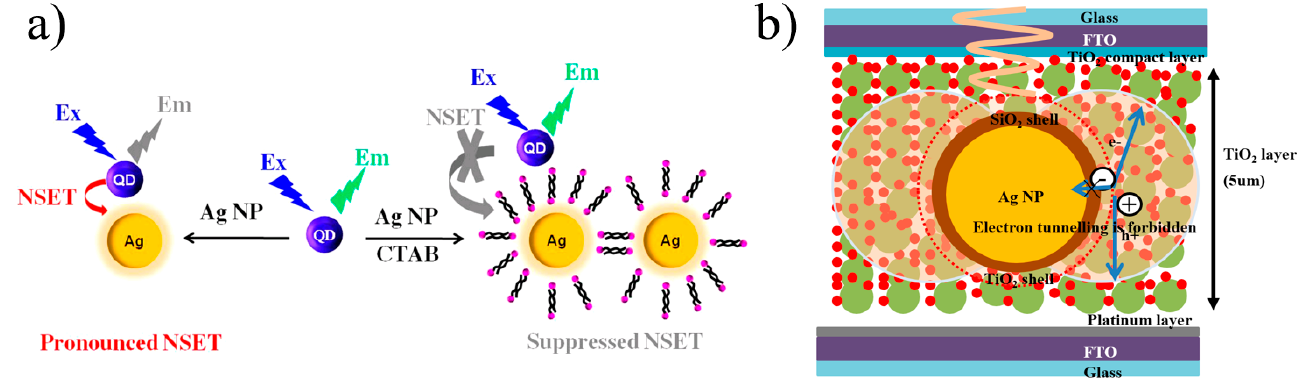
Figure 19. ( a ) Schematic diagram of NSET between AgNPs and Si QDs [87]. ( b ) Schematic drawing of the core–shell–shell nanoparticle structure. Adapted from Ref. [88].